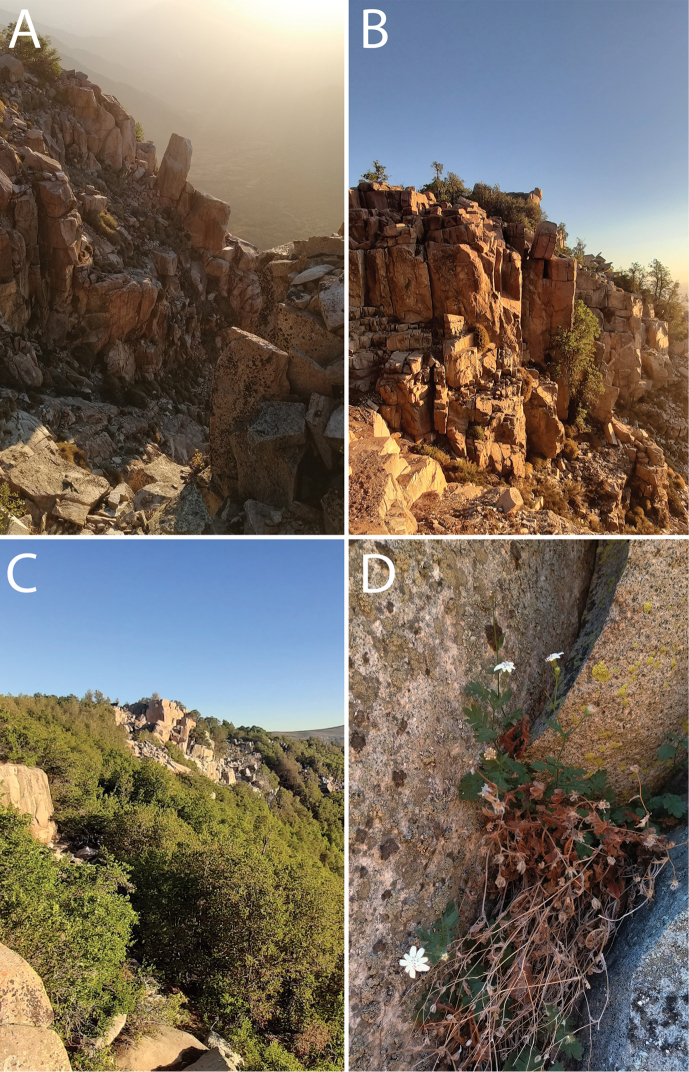
Habitat of Leucheria
cantillanensis in Central Chile A southwest facing rock outcrops, ca. 2000 m elevation B rock outcrops in Cantillana, general view C general view of rock outcrops among Nothofagus
macrocarpa (A.DC.) F.M. Vázquez & R.A. Rodr. forests in the Cantillana plateau DLeucheria
cantillanensis, detail of the plant growing between rock crevices. Photographs A, D by Lavandero, B, C by Fabiola Gamboa.